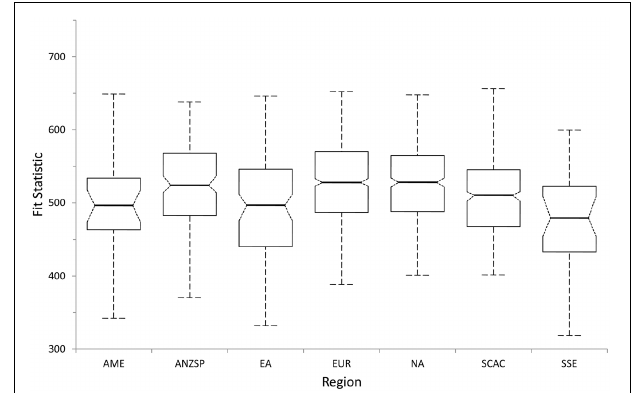
FIGURE 4 | Box plot of median fitness score for respondents from each of seven